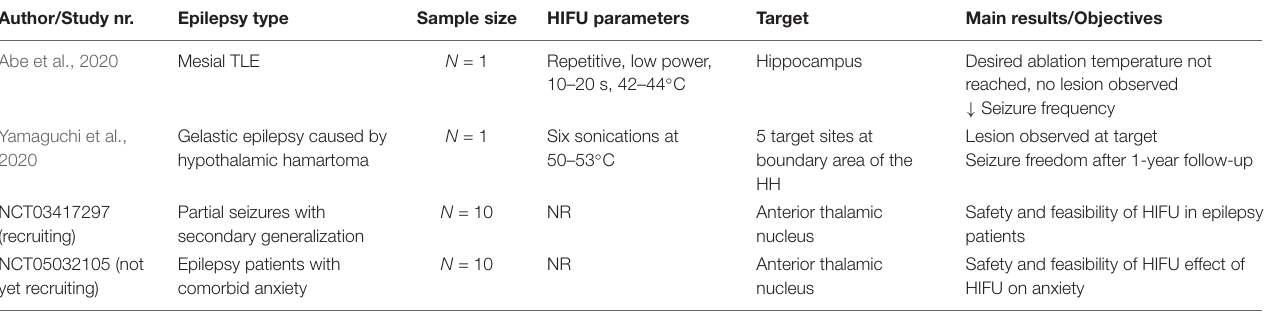
TABLE 2 | Schematic overview of case reports and ongoing clinical trials with HIFU in epilepsy patients. Author/Study